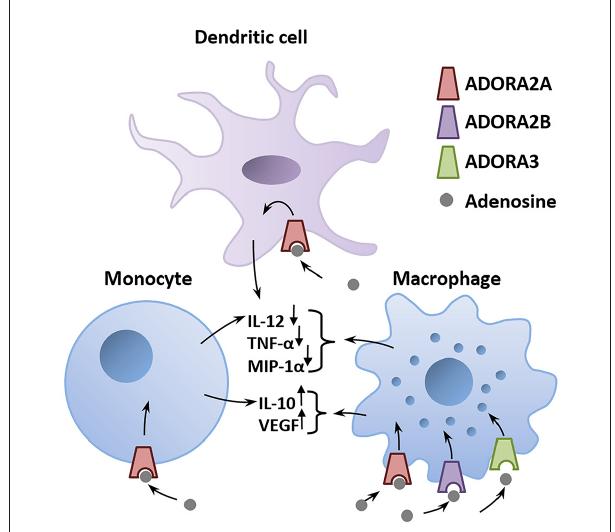
FIGURE2 Adenosine is a critical mediator of the anti-inflammatory immune response. Adenosine is released in the infected tissue from astrocytes and invading immune cells. The binding of adenosine to adenosinergic receptors expressed on immune cells triggers a G-protein–mediated signaling cascade that alters the production of pro- and anti-inflammatory mediators (immune cytokines). Activation of ADORA2A, ADORA2B, or ADORA3 on macrophages, monocytes, and dendritic cells decreases pro-inflammatory mediators including IL-12, TNF- α , MIP-1 α and increases the secretion of the anti-inflammatory IL-10 and VEGF (Haskó et al., 2005). Abbreviations : ADORA2A, adenosine A2A receptor; ADORA2B, adenosine A2B receptor; ADORA3, adenosine A3 receptor; IL-10, interleukin-10; IL-12, interleukin-12; MIP- 1 α , macrophage inflammatory protein-1 α ; TNF- α , tumor necrosis factor- α ; VEGF, vascular endothelial growth